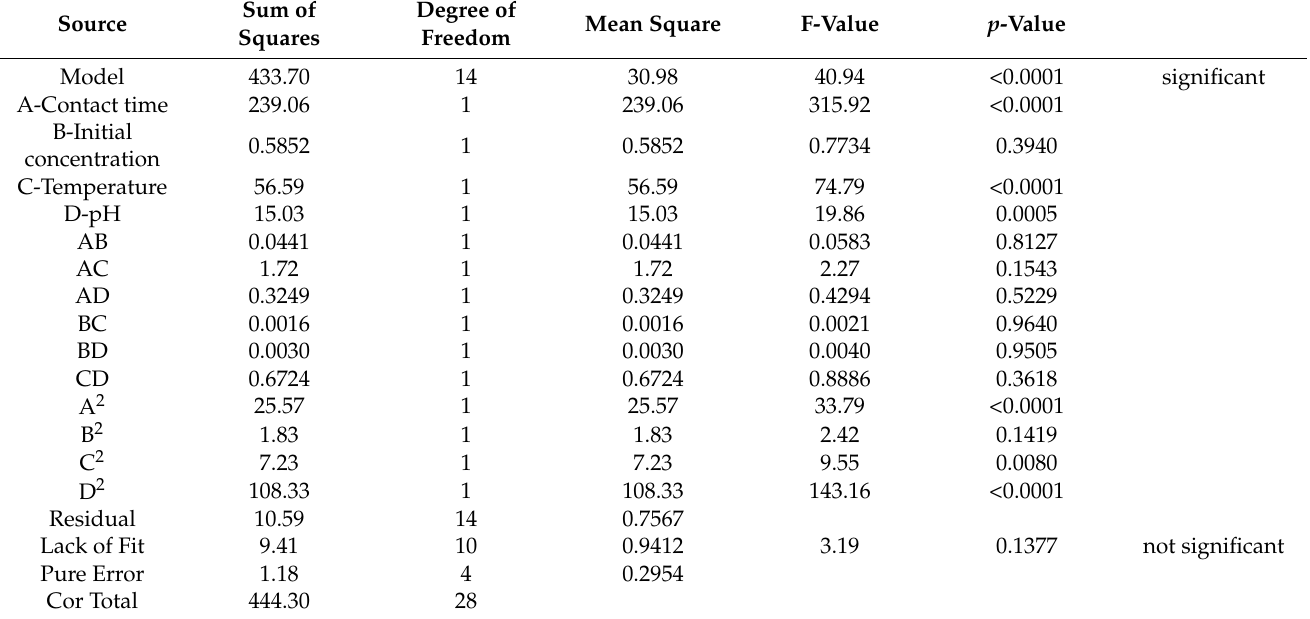
Table 8. Analysis of variance (ANOVA) of the second-order polynomial equation.